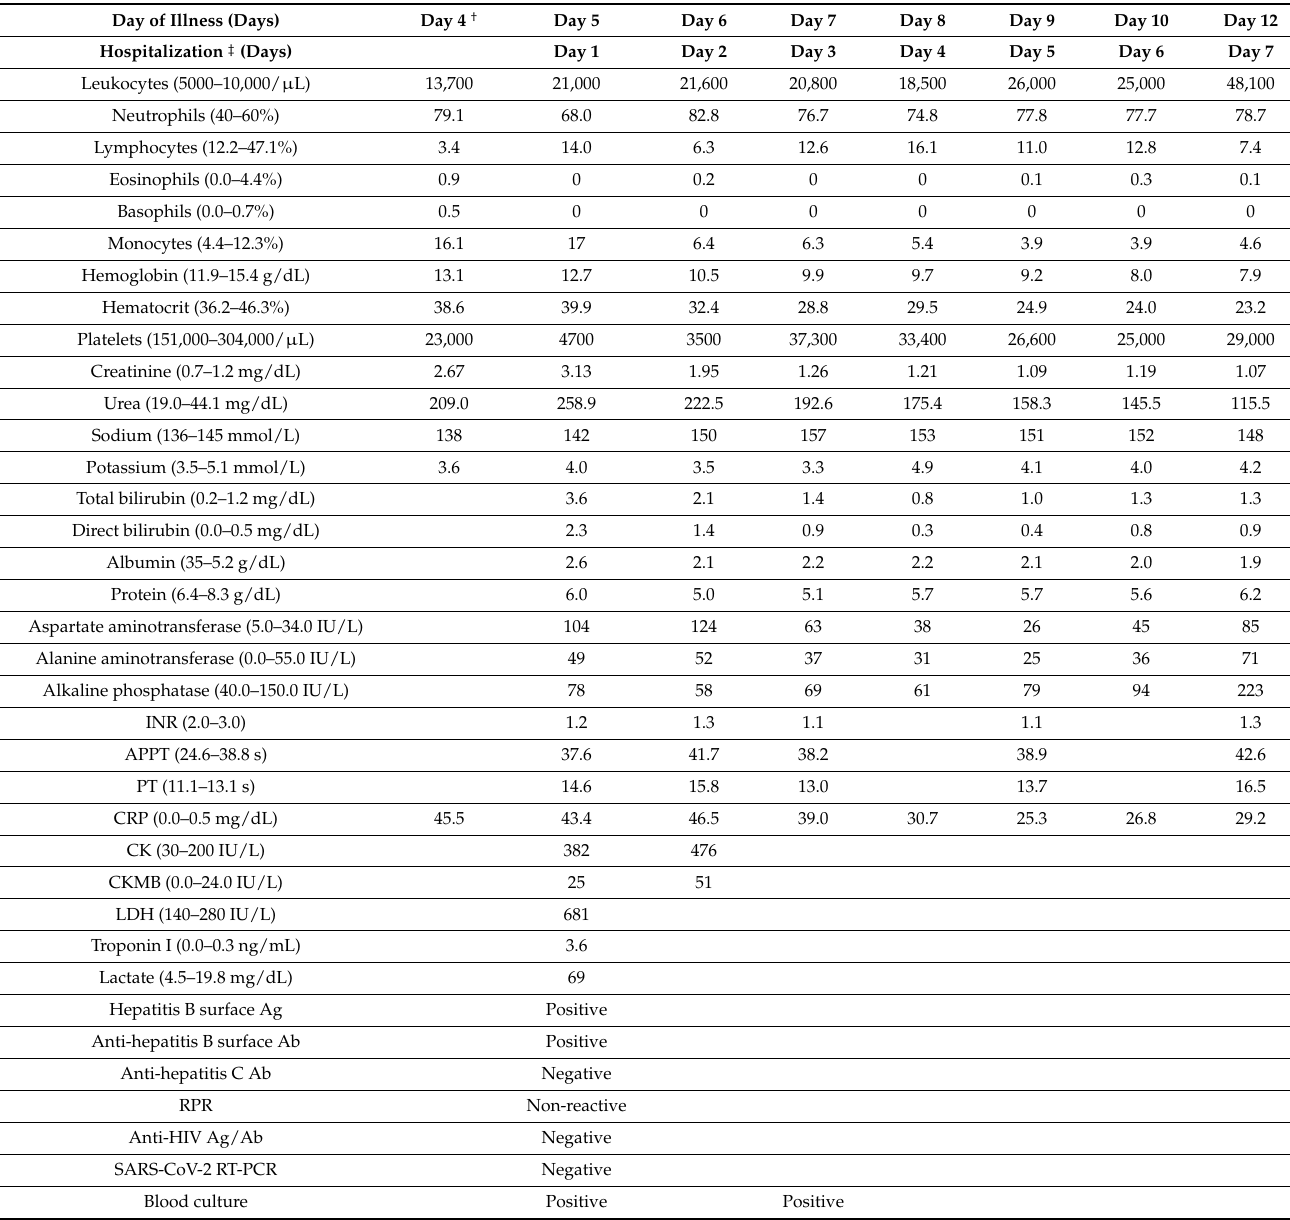
Table 1. Laboratory investigations performed over the course of the